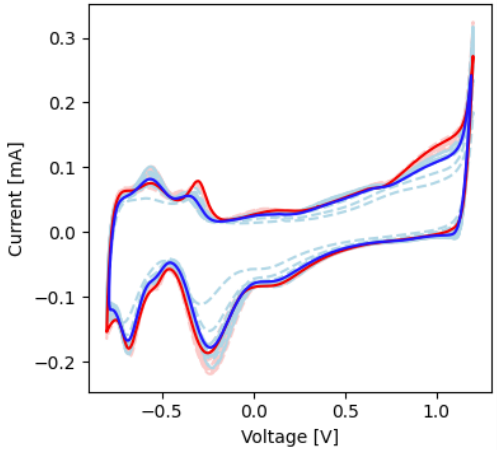
Figure 8. CV plots before and after long-term electrochemical testing. The dashed red and blue lines represent measurements made before and after soak an eletrical stimulation, respectively. The solid red and blue lines are the averages of the values before and after soak and electrical stimulation, respectively.